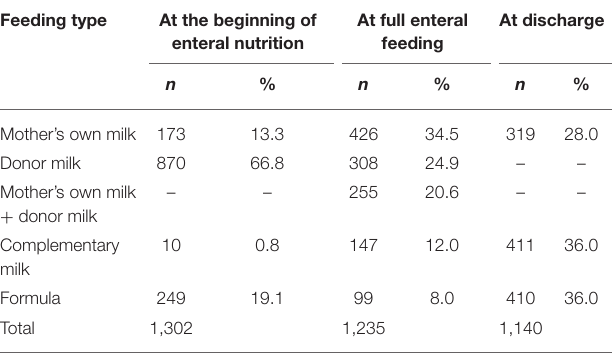
TABLE 2 | Feeding type at different times during